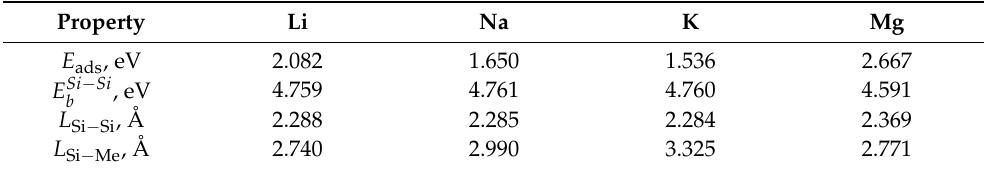
Table 1. Bond characteristics of alkali metal and magnesium atoms calculated at their adsorption over the center of a six-member ring of